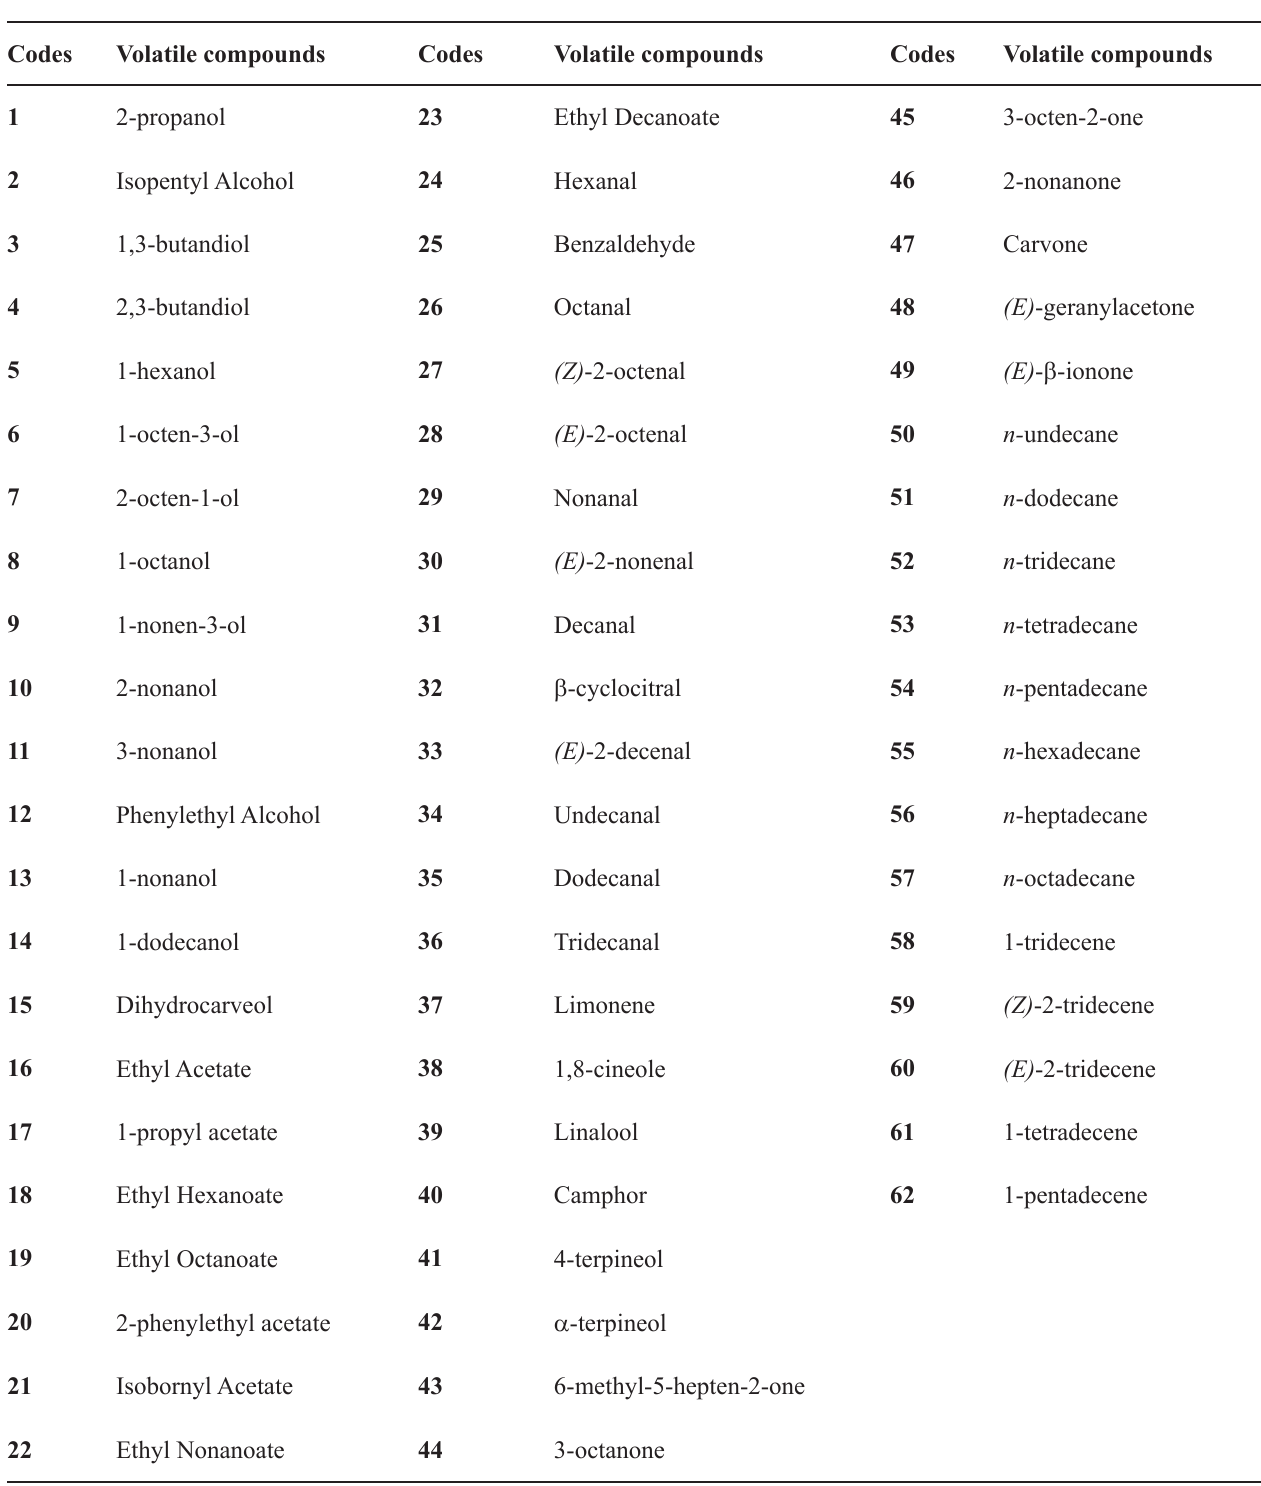
TABLE V - L ist of variables used for the multivariate statistical analysis